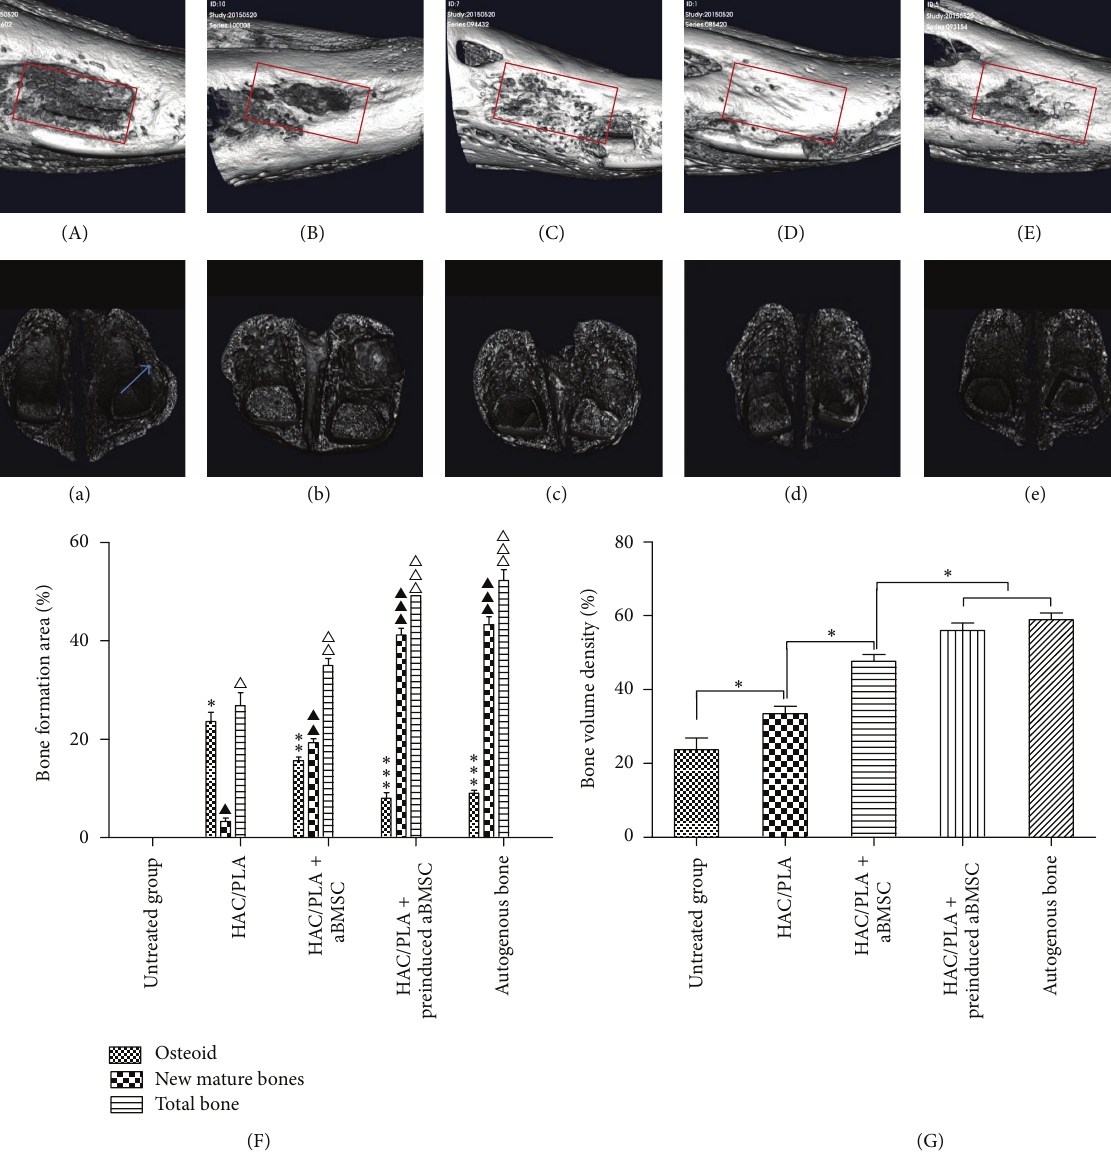
Figure 7: Micro-CT images of the mandibular defects at 8 weeks after implantation. (A, a) The critical-size bone defect in the untreated group was unfilled. (B, b) For defects filled with an nHAC/PLA scaffold, new bone formation in the open scaffold pores, with incomplete healing on the surface of the defect, was observed. (C, c) The defect surface was healed with a thin cortical shell bridge in the nHAC/PLA + aBMSCs group. (D, d) The defect surface was completely healed with a thick cortical shell bridge in the nHAC/PLA + preinduced aBMSCs group. (E, e) In the AB group, the defect healed well, and the iliac graft block and mandibular bone could not be distinguished. (The red boxes represent the defect area in the mandible, and the blue arrow indicates an incomplete cortical shell.) (F) The percentages of osteoid tissue formation, mature bone formation, and total bone formation were determined by histomorphometric measurements. Differences are significant at 𝑝 < 0.05 . Groups with the same symbol ( ∗,󳵳, 󳵻 ) were not significantly different. (G) The bone volume density in micro-CT is presented as the percentage regeneration of the defect. Differences are significant at 𝑝 < 0.05